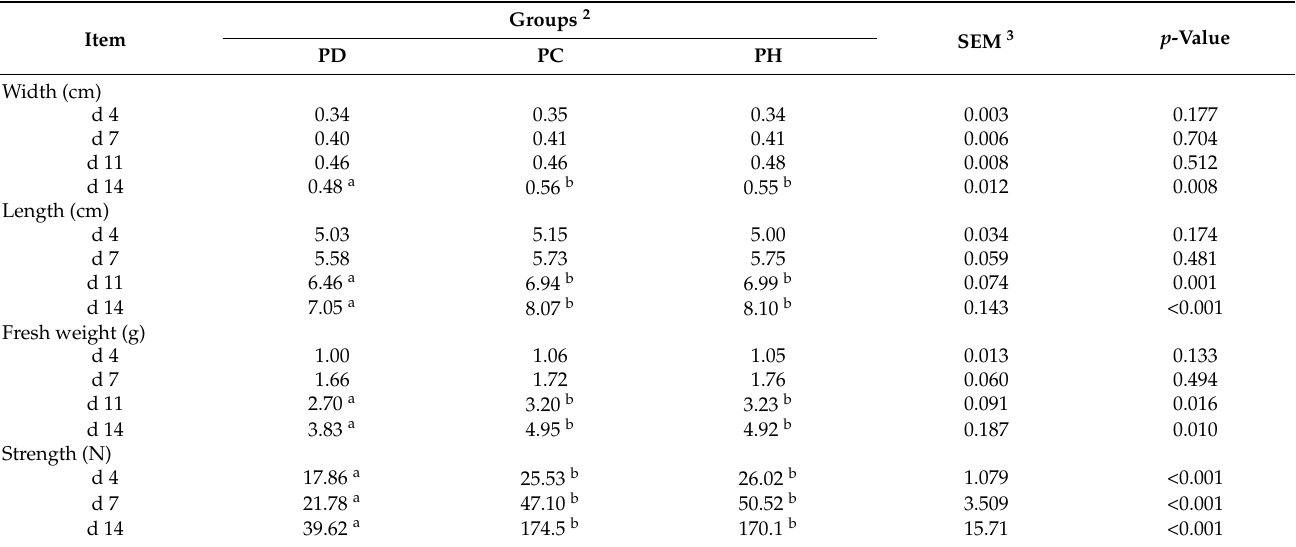
Table 6. Effects of dietary phosphorus (P) deficiency and high P content on tibial development in goslings.